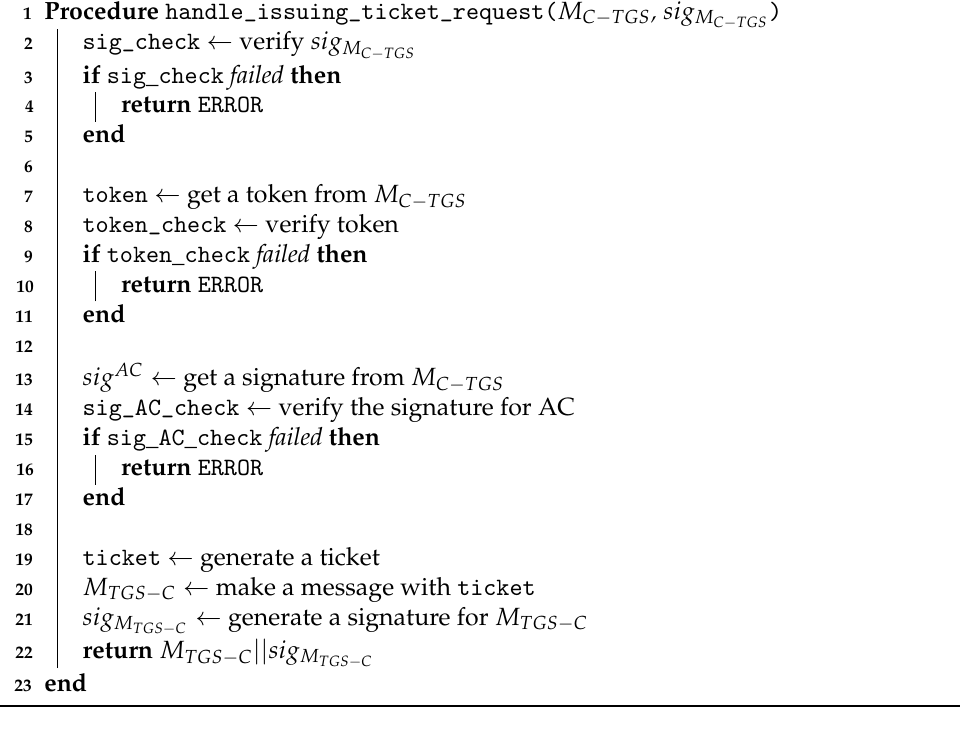
Algorithm 6: The ticket issuing algorithm on the TGS side